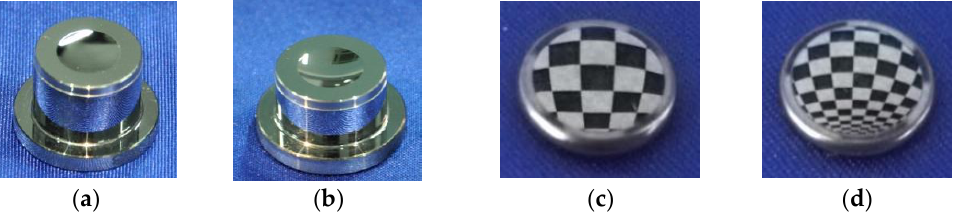
Figure 21. Photographs of aspherical molds and aspherical lens: ( a ) upper mold, ( b ) lower mold, ( c ) upper surface of aspherical lens, and ( d ) lower surface of aspherical lens.